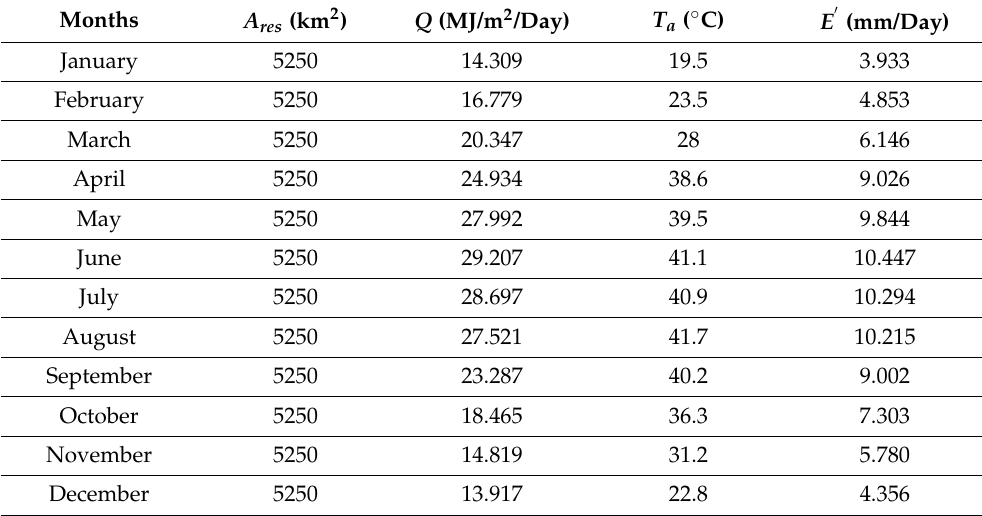
Table 1. Parameters and variables calculated for Lake Nasser, city of Aswan, Egypt (22 ◦ 25 (cid:48) N 31 ◦ 45 (cid:48) E).